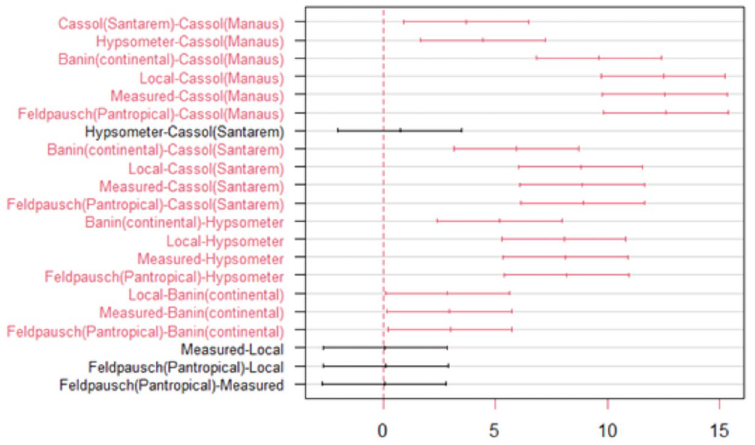
Fig 5. Intercomparison of average heights estimated by local, regional, continental and pantropical allometric models, by hypsometer and data measured in the field. The red contrasts indicate a statistical difference of zero by the Tukey test (p <